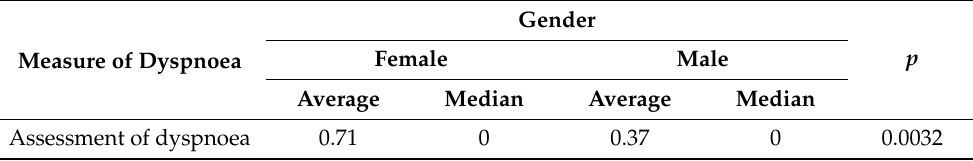
Table 7. Gender and level of